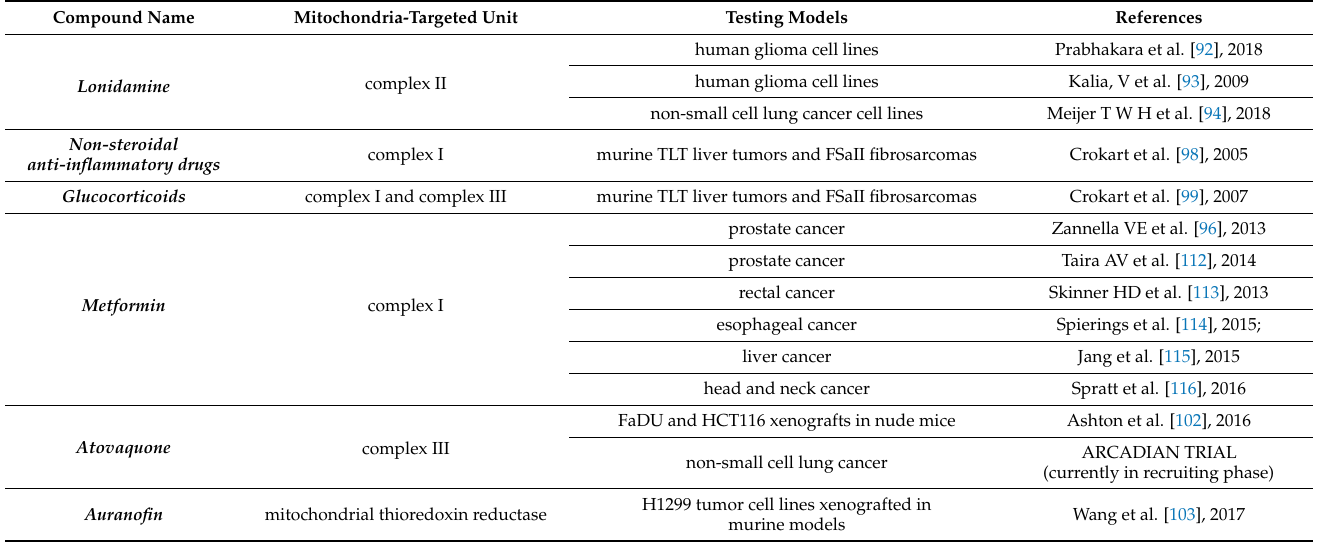
Table 1. Summary of the combined principal radiotherapy − mitochondria targeting strategies to enhance